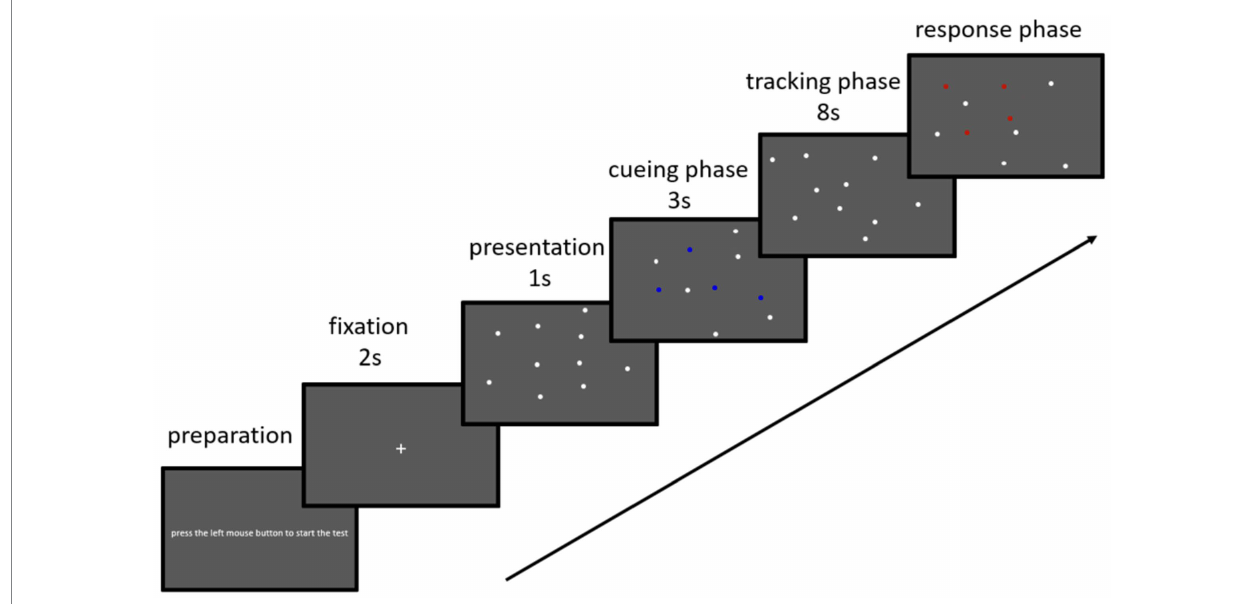
FIGURE 1 Schematic diagram of the visual stimuli presented in one trial of the multiple object tracking task. Ten filled white circles are presented on the screen. In each trial, four of the circles turn blue and flicker for 3 s before turning back to white. The blue flickering circles indicate the targets for that trial. All 10 circles then move 10 ° /s for an 8-s tracking period. When the circles stop moving, the participants use a mouse to click over their choices for the target circles.